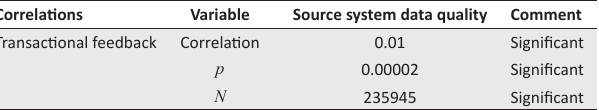
FIGURE 6: Source system and feedback-based data quality per financial year. TABLE 4: Correlation between source system data quality on transactional